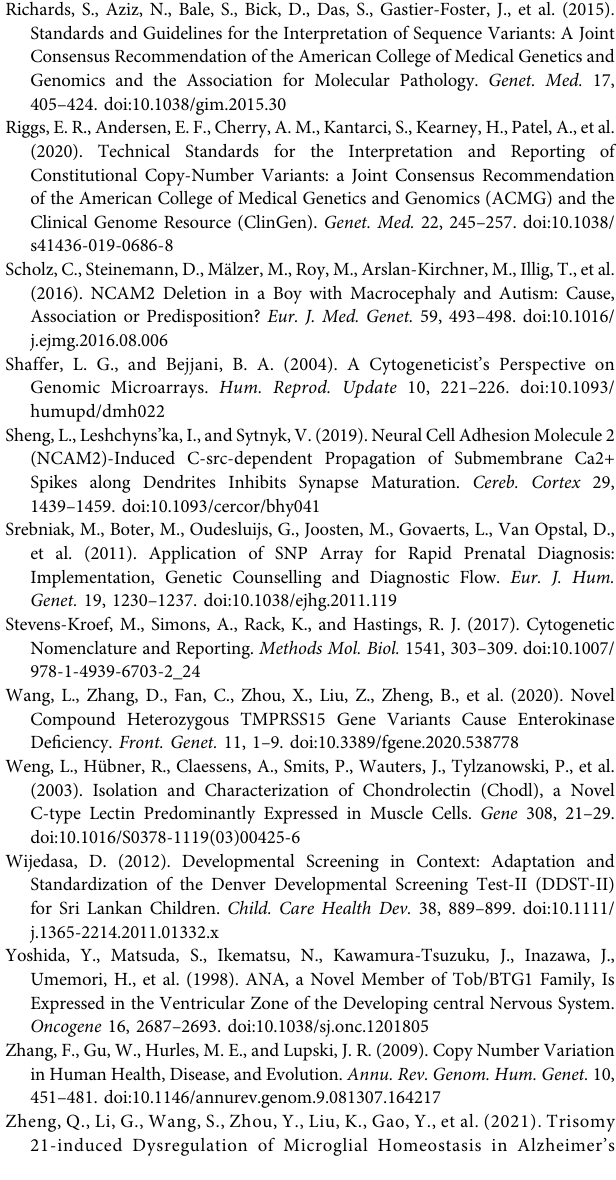
Supplementary Figure 1 | Single-nucleotide polymorphism (SNP) array results for the fetuses. Pedigrees 1 – 6: 21q21.1 – 21.2 duplications, with fragment sizes in